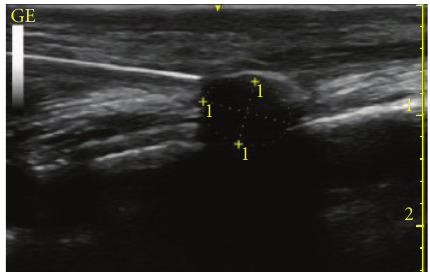
Figure 4: Cryolesion (diameter = 0.80 cm) at 1 minute and 30 seconds into the freeze cycle. Note the hyperechoic rim with posterior acoustic shadowing emanating from the tip of the probe.